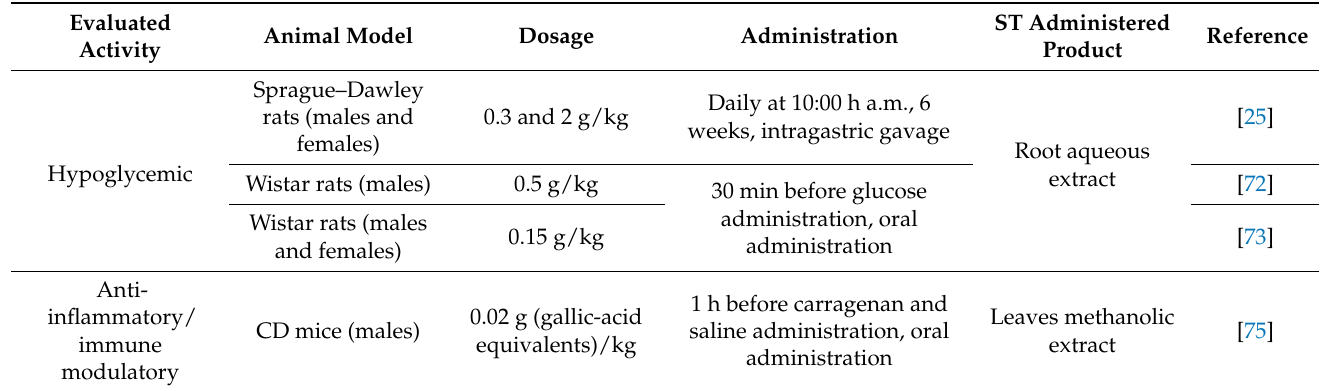
Table 5. Dosage and administration time of ST extracts for testing biological activities in